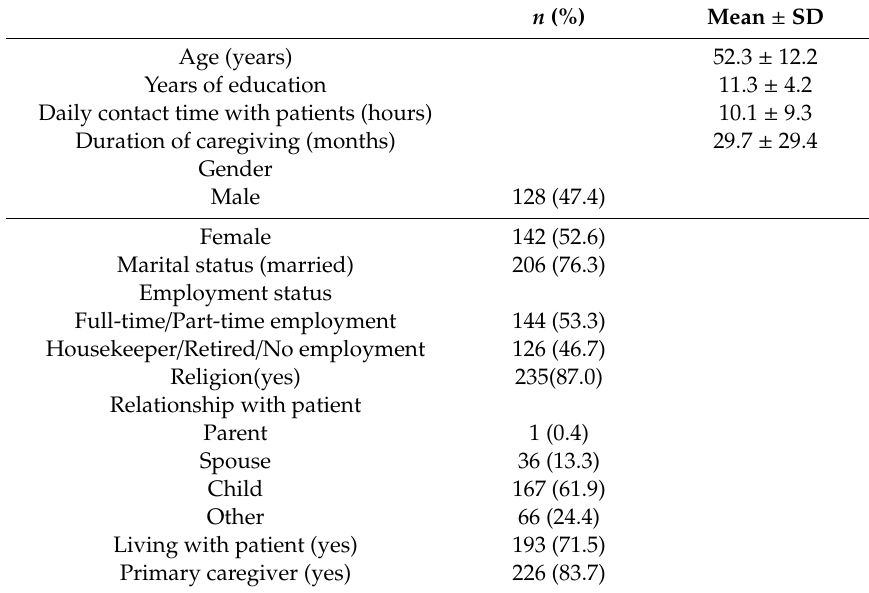
Table 1. Socio-demographic characteristics of family caregivers ( n = 270).